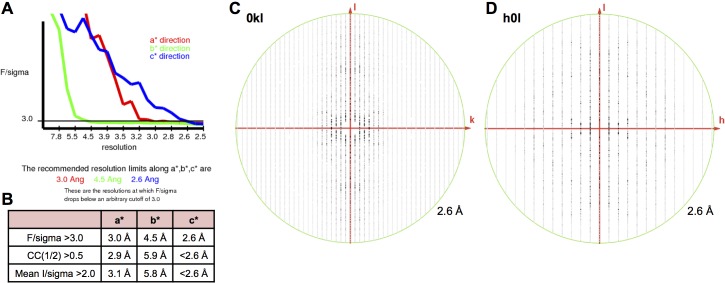
X-ray diffraction anisotropy of the γA4EC3–6 crystal.(A) UCLA Diffraction Anisotropy Server (Strong et al., 2006) output showing the data strength as measured by F/sigma along the a*, b*, and c* axes. (B) The diffraction limits along the a*, b*, and c* axes determined by three different methods: F/sigma from A, and the correlation coefficient (CC) and I/sigma limits calculated by Aimless (Evans, 2006; Evans and Murshudov, 2013). (C–D) Synthetic precession photographs of the X-ray diffraction in the h = 0 plane (C) and the k = 0 plane (D) showing the much weaker diffraction along k and slightly weaker diffraction along h.